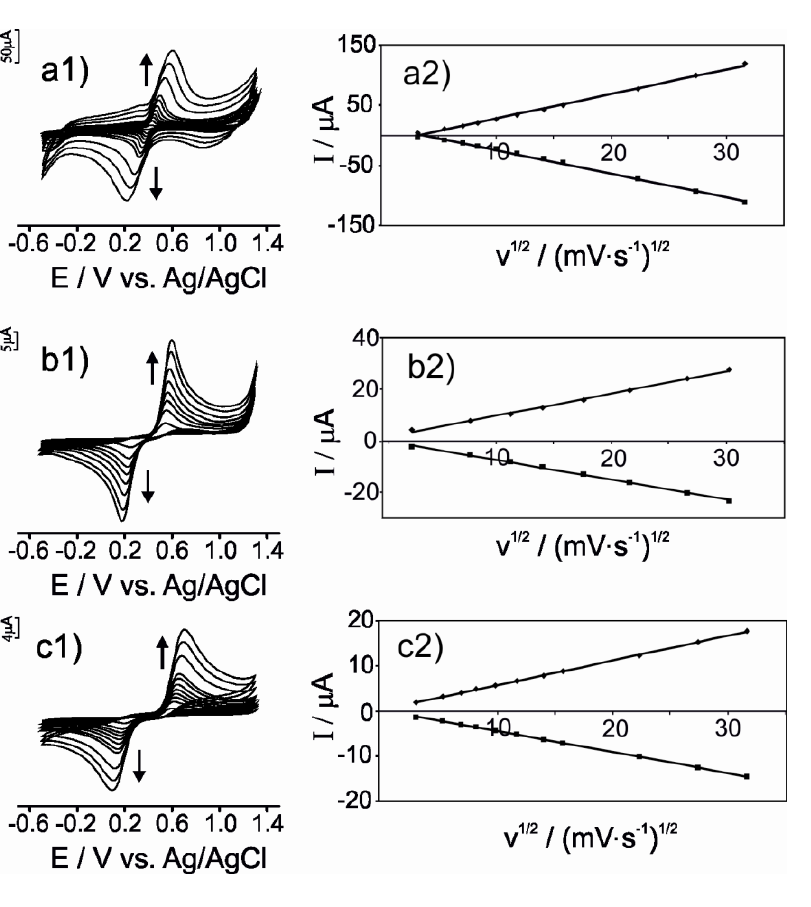
Figure 5. Cyclic voltammograms of: (a1)  S-CPE; (b1) G-CPE; (c1) CNT-CPE in 4 × 10 −4 mol L −1 catechol (pH 3.6) registered with different scan rates (0.01−1.0 Vs −1 ). (a2) ; (b2) ; (c2) Plots of I versus v 1/2 , respectively I versus v 1/2 pa pc